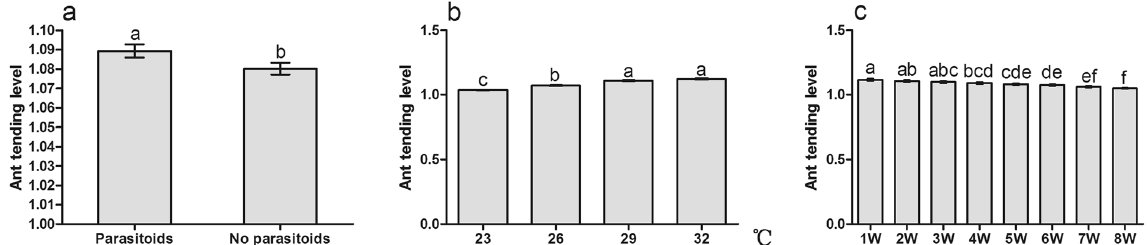
Figure 3. Effect of the presence of parasitoids, temperature warming, and investigation date on ant tending level. ( a ) Parasitoid; ( b ) Temperature; ( c ) Investigation date. Results are expressed as the means ± SE. Bars sharing the same letters indicate no significant differences between the treatments ( P > 0.05).